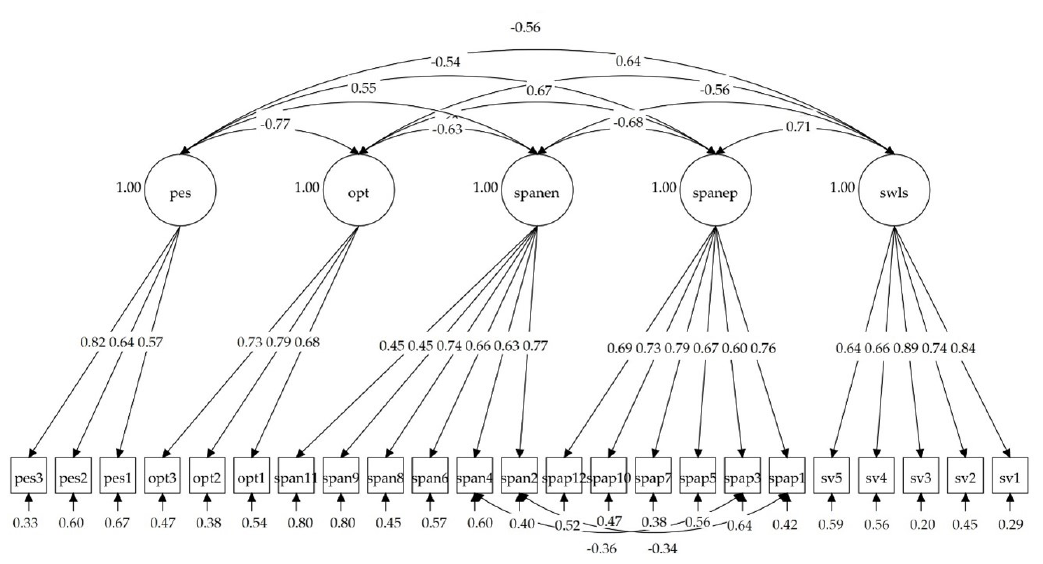
Figure 4. Path diagram for the concurrent validity model with correlation coe ffi cients among latent variables and factorial loadings; pes: Life Orientation Test (pessimism subscale); opt: Life Orientation Test (optimism subscale); spanen: Scale of Positive and Negative A ff ects (negative subscale); spanep: Scale of Positive and Negative A ff ects (positive subscale); swls: Satisfaction with Life